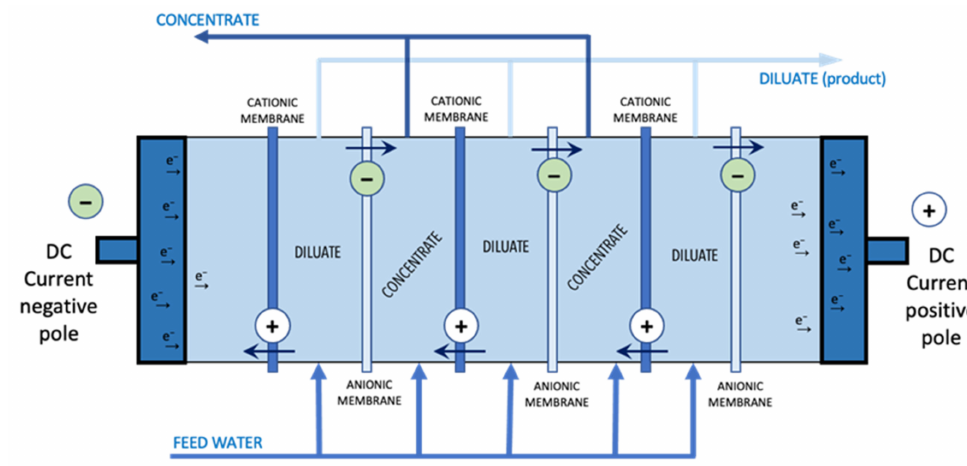
Figure 3. Schematic view of the electrodialysis (ED)